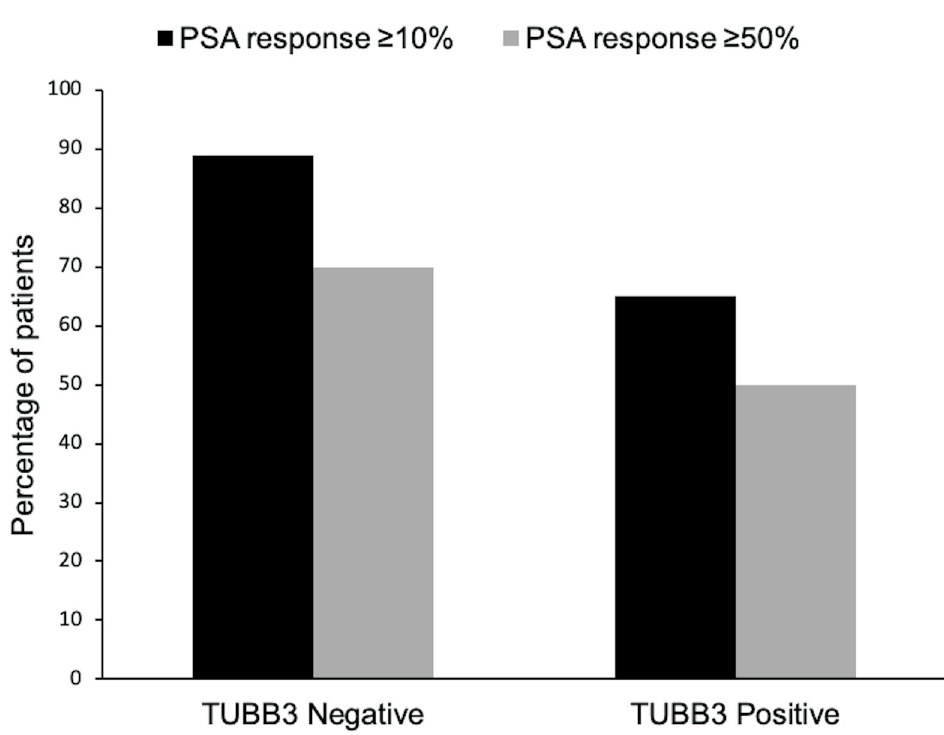
Fig 2. Class III β -tubulin ( β III-tubulin) expression and response to treatment with different PSA cutoffs. β III- tubulin expression was considered high if immunostaining was moderate or strong (2+ or 3+) and low if staining was absent or weak (0 or 1+). Response to treatment was assessed via PSA measurement. Results were statistically significant when comparing percentage of patients with high vs. low expression of β III-tubulin using the 10% cutoff (p =